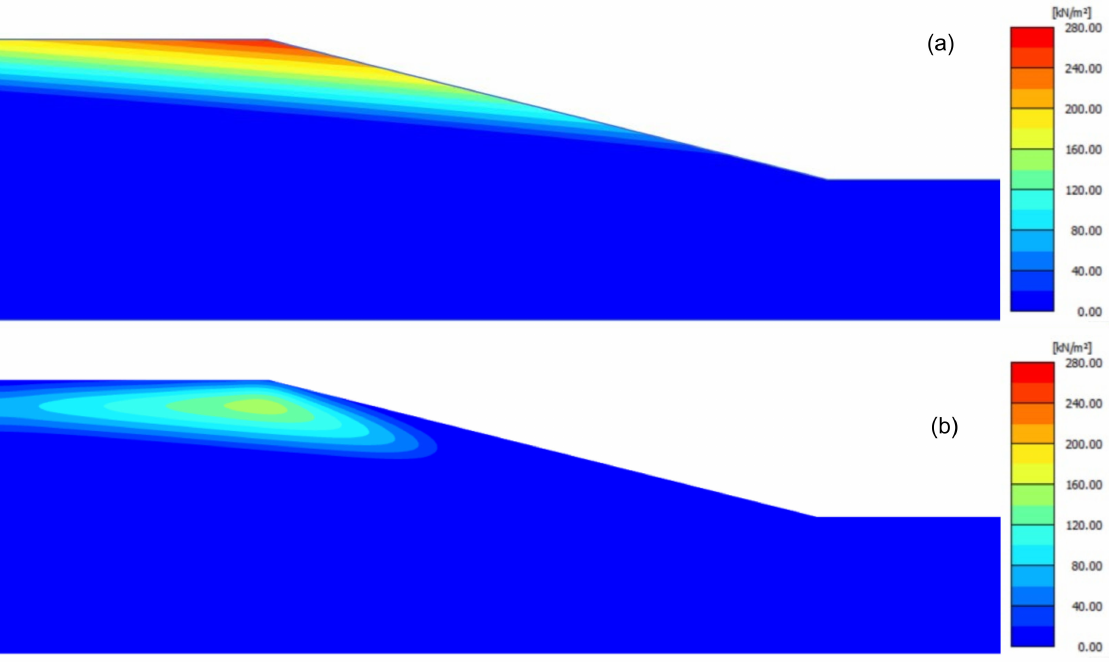
Figure 9. Distribution of matric suction for the reference slope ( a ) at the initial stage and ( b ) at the final